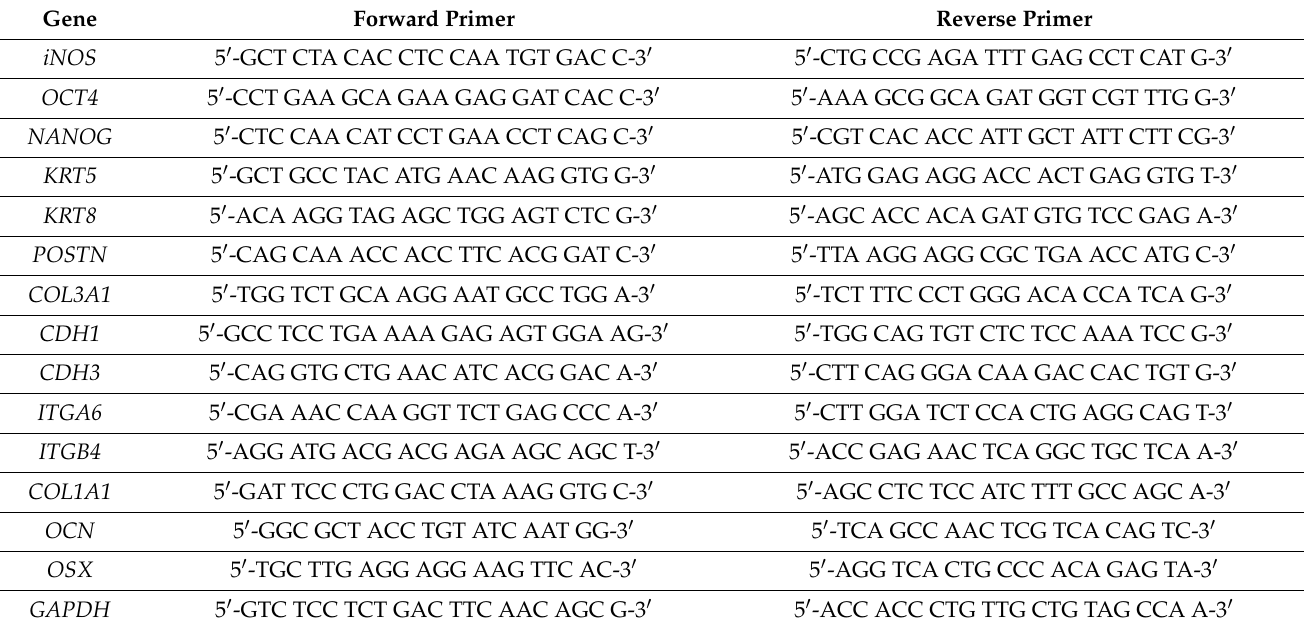
Table 1. List of